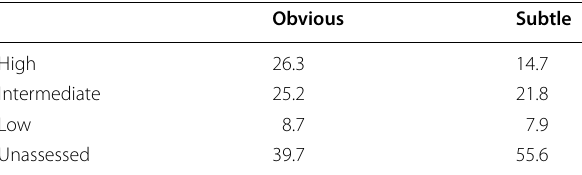
Table 3 Percentage of mammograms with a high, intermediate, low, or unassessed DCIS grade for the obvious and subtle subsets of the image set. Where descriptors were not available in the OPTIMAM database, the mammogram was classified as unassessed